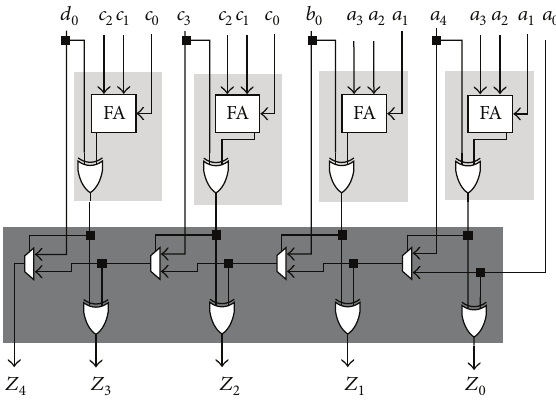
Figure 4: FPGA realization of (1, 4, 1, 5; 5) GPC using fast carry chain.